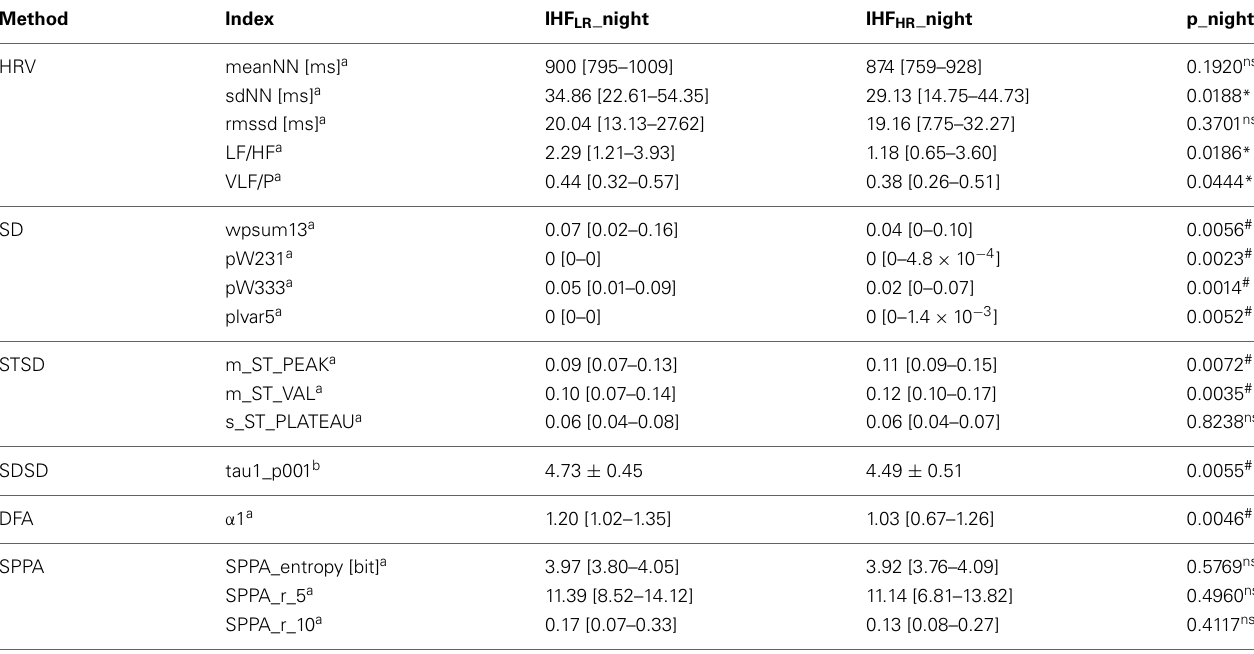
Table 5 | Analysis of 30min most stationary beat-to-beat interval segments of the night phase- univariate statistical analysis results ( U –test) to discriminate between patients with ischemic heart failure at low risk and at high risk (IHF LR and IHF HR